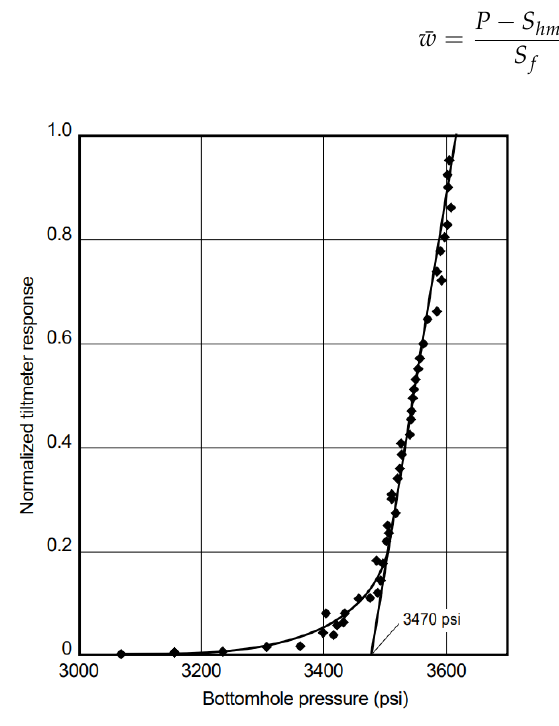
change in pressure is linear, as given by Equation (19) [45,46].